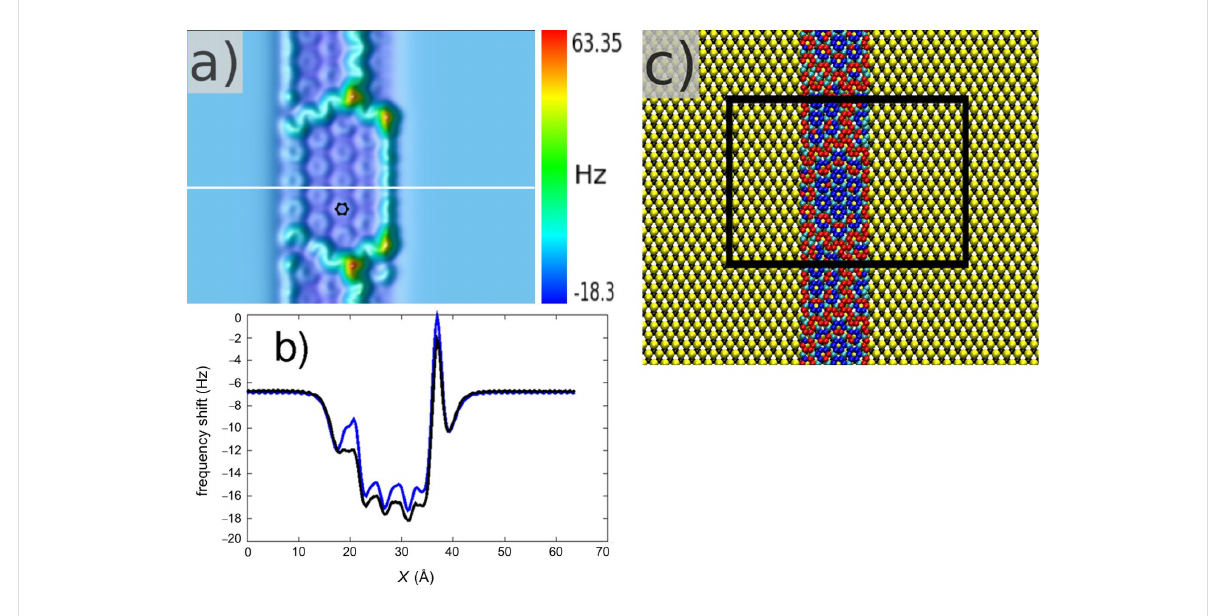
Figure 4: (a) FM-AFM calculated image of a graphene nanoribbon with H set = 3.8 Å. The Δ f corrugation is 81.68 Hz. The image size is 63.9 × 50.1 Å 2 , which corresponds to the black area in (c). (b) Scan lines above the white line in (a) for the frozen-atoms (blue) and free-atoms (black) regimes. (c) Atomic model of the reconstructed GNR (same color code as in Figure 3d) on the SiC substrate (yellow, silicon atoms; black, carbon